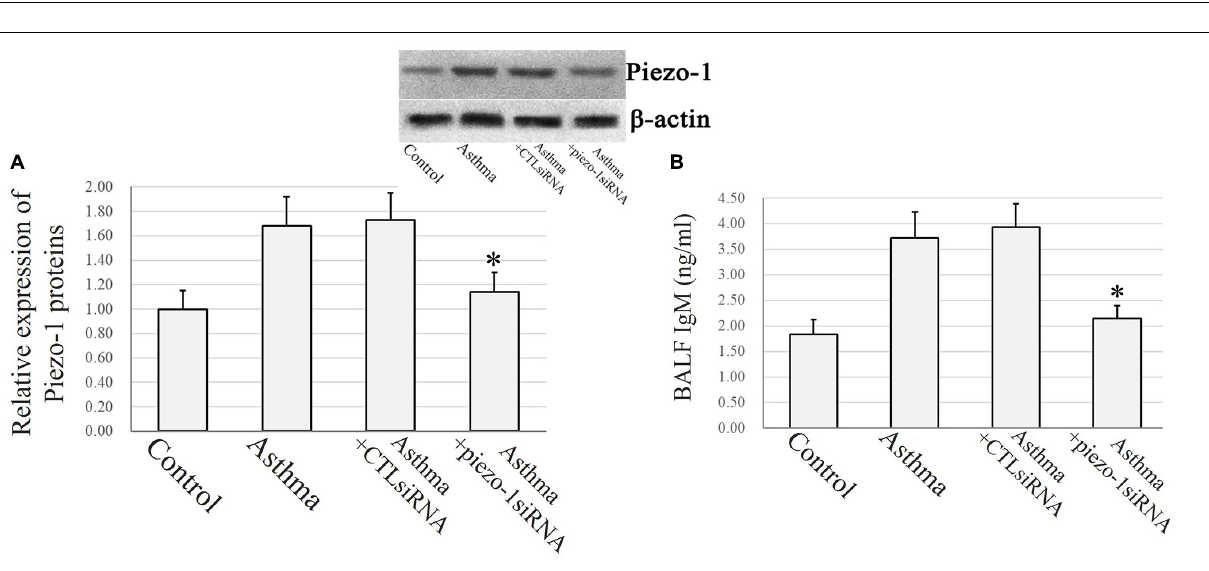
FIGURE 2 | Piezo-1 might be responsible for the increased airway permeability in asthmatic mice model. (A) Western blot assay to detect the piezo-1 protein. Tissue piezo-1 levels are described as relative expression normalized to that of β -actin. Data are represented as the mean ± SD, n = 6. * P < 0.05 vs. asthmatic mice. (B) Airway permeability based on the transit of IgM to the airway was increased in asthmatic mice. Piezo-1siRNA airway transduction partially abolished the increased IgM. ∗ P < 0.05 vs. asthmatic mice. Data are represented as mean ± SD, n =